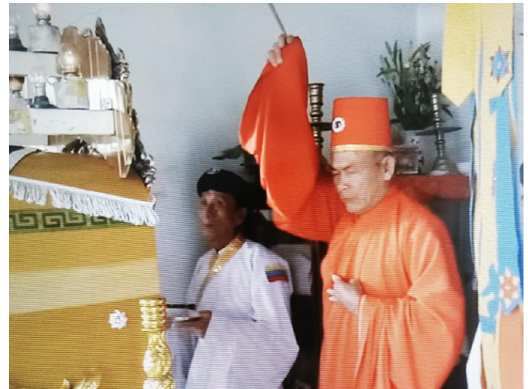
Figure 11. Talismanic writing for Hành pháp Độ th ă ng , performed by a priest of Tây Ninh branch; funeral of Mrs Lê Th ị L ự c, 12 July 2017 (Ph ướ c D ươ ng 2017).